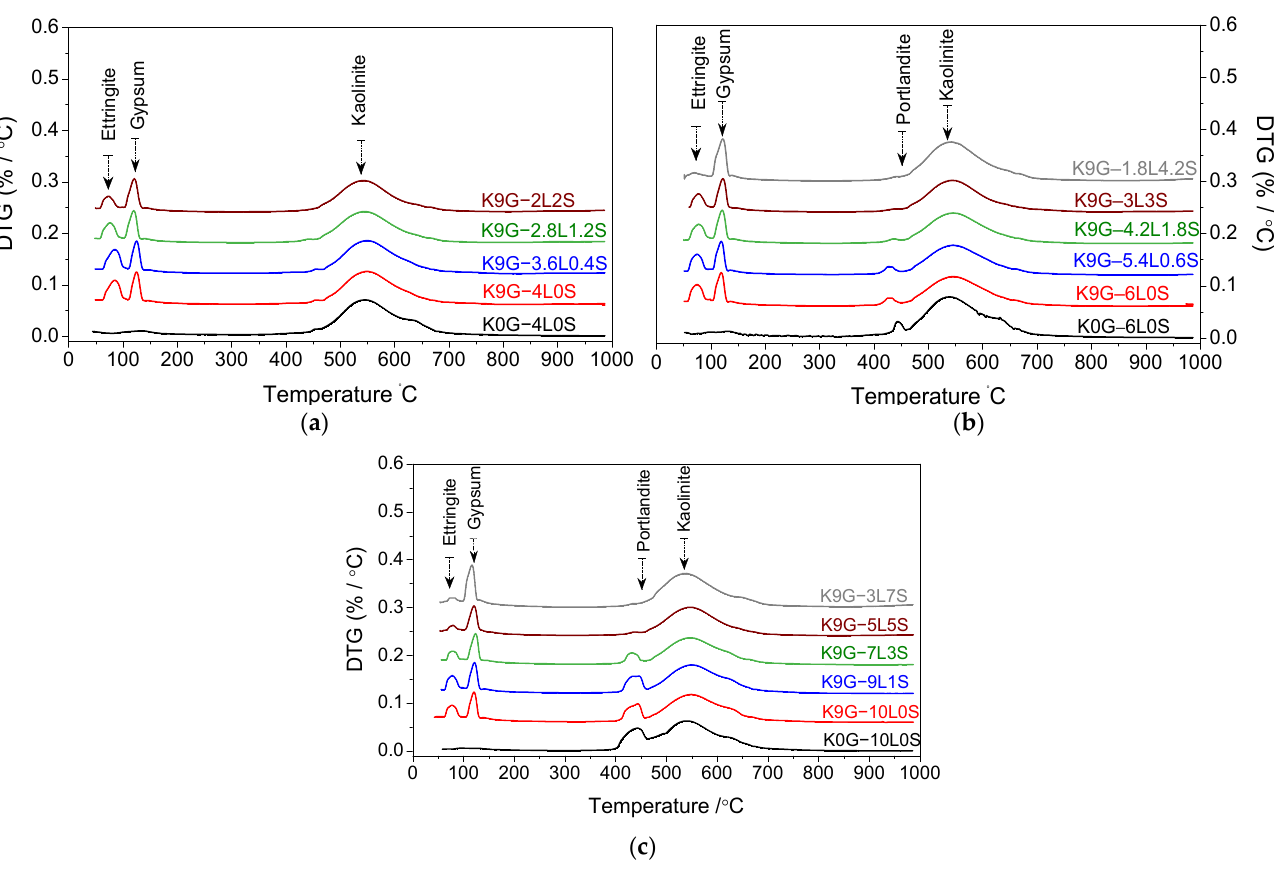
Figure 7. The 7-day DTG curves of kaolinite specimens made with various binary blends of lime and silica fume at three different binder dosages: ( a ) 4, ( b ) 6, and ( c ) 10 wt%.